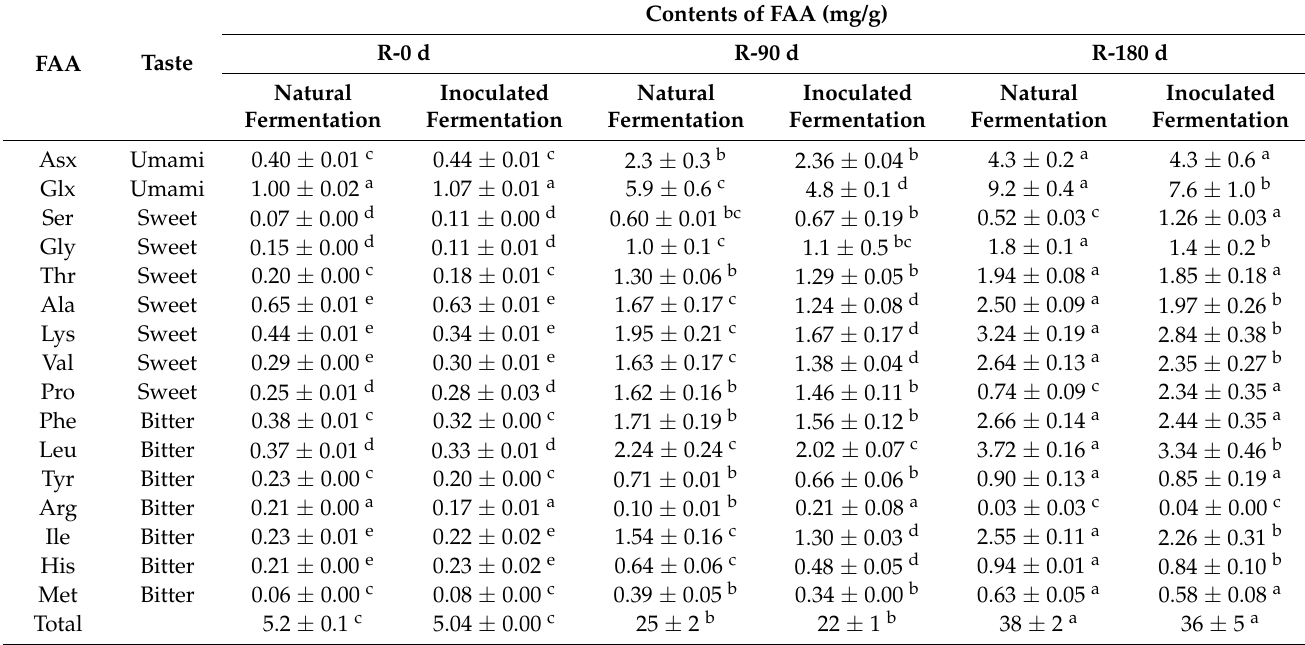
Table 3. Contents of FAA in natural and inoculated fermented sufu.